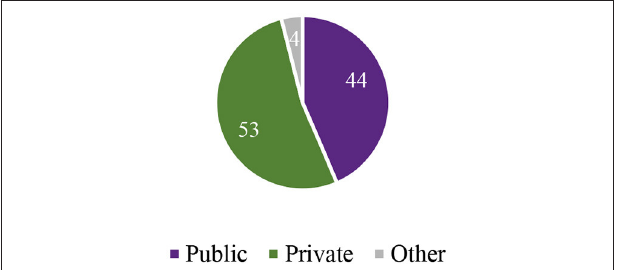
FIGURE 4 | Percentage distribution of utilization of healthcare facilities in India,